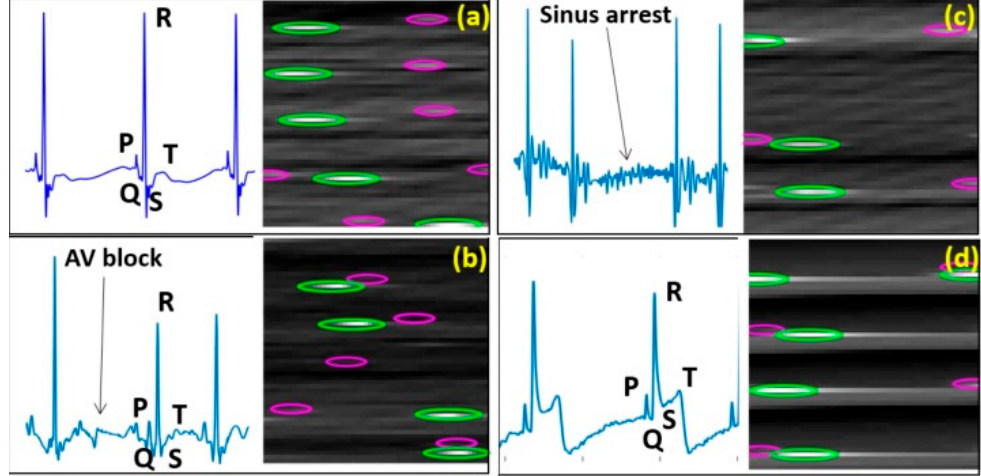
Figure 8. Exemplary standard ECG patterns and exemplary conversion images for CNN training to indicate general differences in the presentation of wave morphology. ( a ) Control fish; ( b – d ) Mutant lines with phenotypes of AVB, SA and STE, respectively. Green: R peaks; Pink: P peaks.